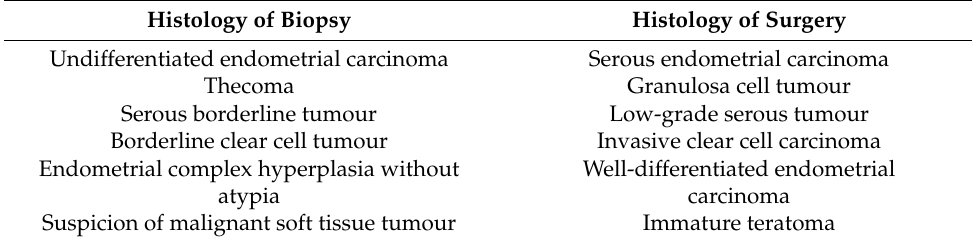
Table 5. Histologic results of the